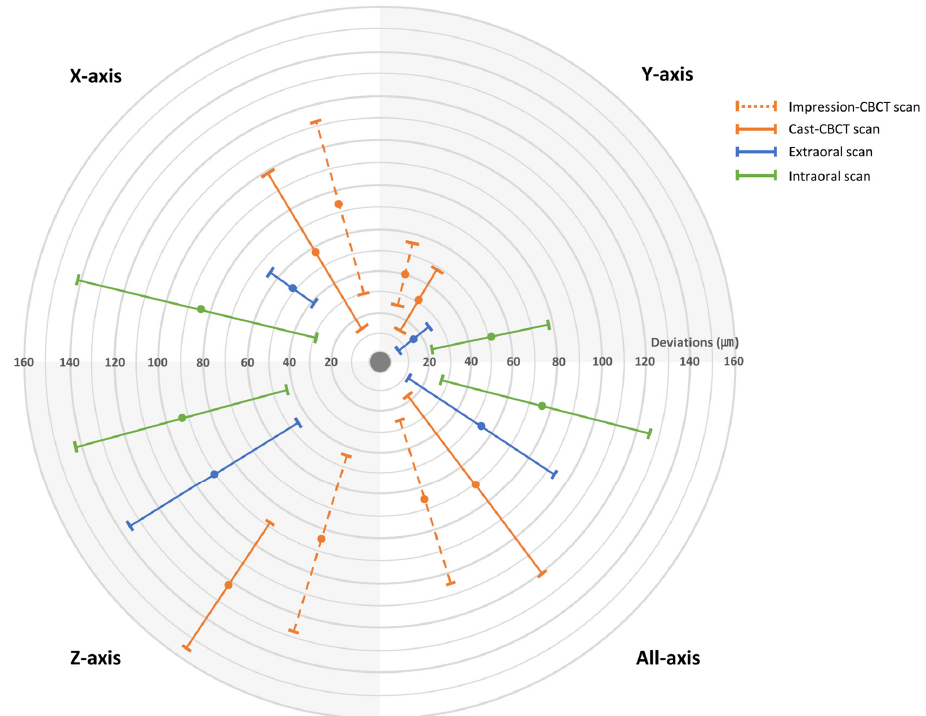
Figure 4. The accuracy of digitized model is described in a target figure, and the center of the target is determined as the true model value. The digitized model is more accurate when the mean deviation value is close to the target center. The model is also more consistent in linear dimension when the marked range is narrow. Each section of the target represents a different axis. The upper left section represents the X-axis, the upper right represents Y-axis, the lower left represents the Z-axis and lower right represents the total. The mean deviation value is marked with a circle, and the standard deviation is marked as a